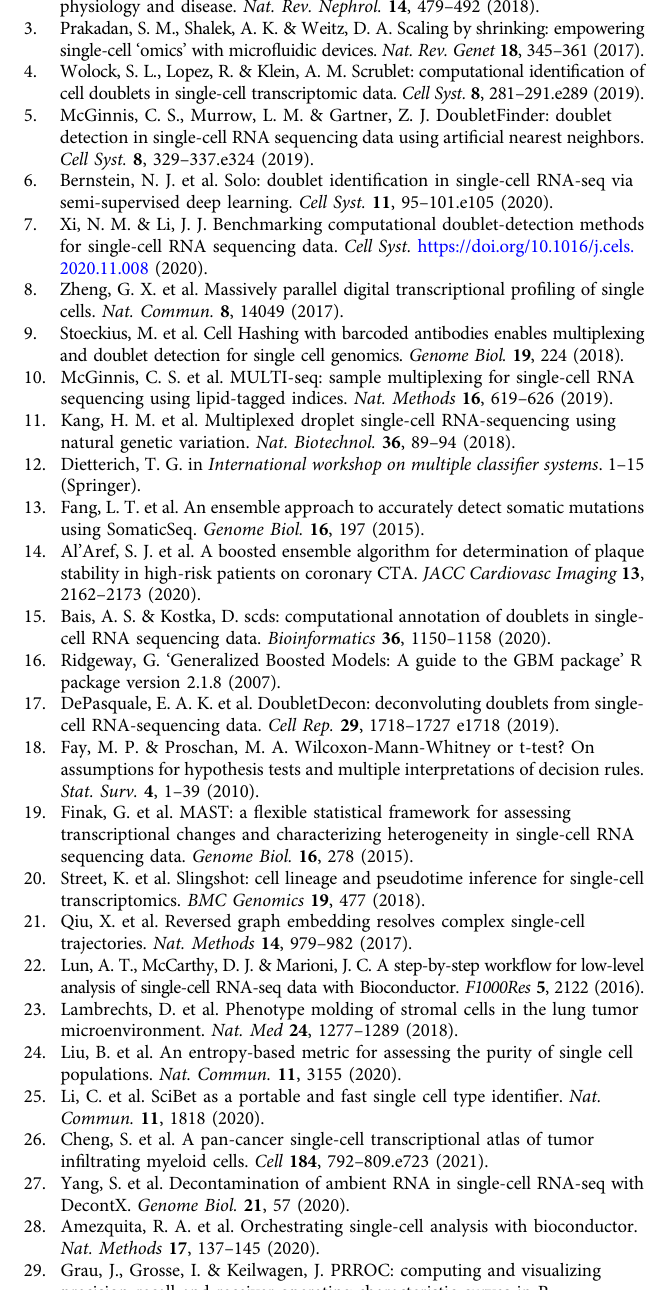
Fig. 4 Doublet removal by Chord improves the analysis performance on real-world scRNA-Seq data. a Doublet detection was performed on the published lung cancer dataset 23 using Chord. The number and the proportion of doublets for each cell type which was labelled by original paper were recorded. b UMAP of the 24,280 cells in this dataset. The cells were coloured by cell type (left), the predicted result of doublet detection (middle) and the clusters were de fi ned by Seurat (right). c A bar chart showing the number of doublets and total cells in each cluster. d Heatmap of marker genes for doublets (in cluster 10), T Cells, and Plasma cells. e The ROGUE value 24 of each cell type for each sample. A paired t -test was used to test the difference in each cell type in each sample between the two groups before and after doublet fi ltration (paired t -test, * p < 0.05, ** p < 0.01, *** p < 0.001, **** p < 0.0001). f A bar chart showing the changes in the total number of differentially expressed genes before and after doublet removal. The DEGs were calculated by the Wilcoxon rank-sum test (Seurat). The threshold value of logFC was measured by a gradient from 0.25 to 0.75 at 0.05 intervals. g The RNA UMI numbers predicted by Chord in each cell type were signi fi cantly different between the doublets and singlets (unpaired t -test, * p < 0.05, ** p < 0.01, *** p < 0.001, **** p < 0.0001). h The myeloid cells in original and fi ltered data for the pseudotime analysis were processed using Slingshot 20 . The trajectory of the original data and the fi ltered data are shown